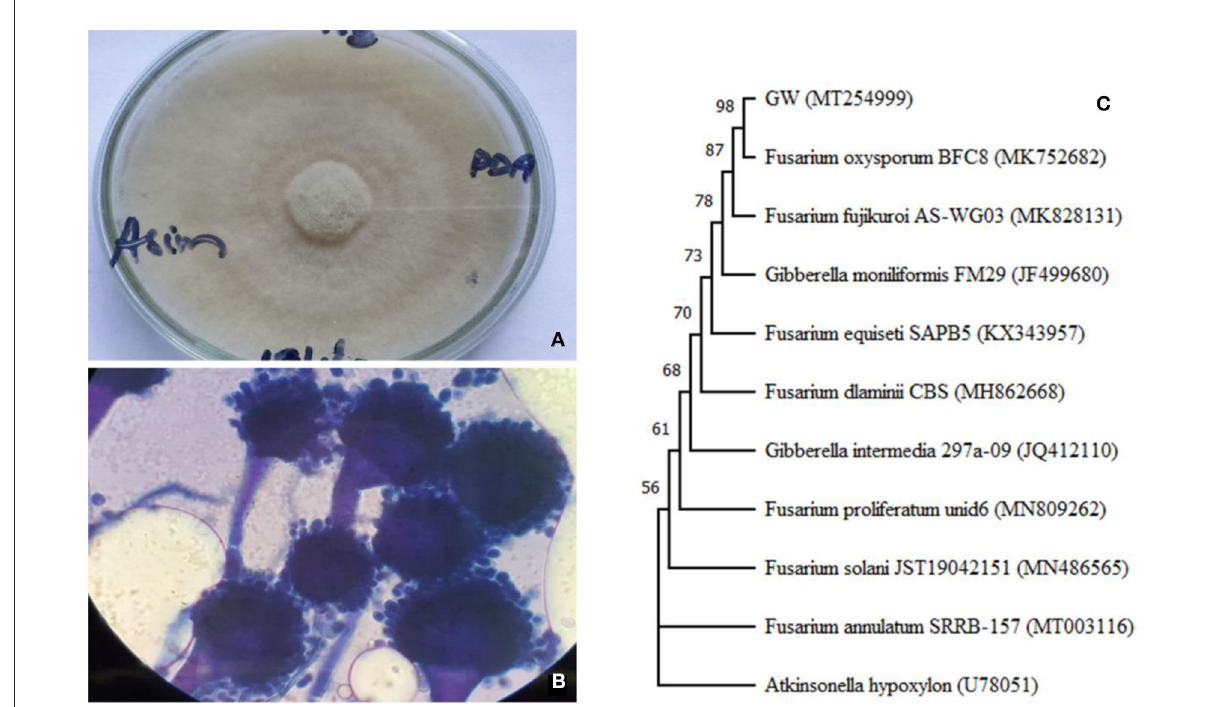
FIGURE1 Colony morphology (A) fungal morphology, (B) light microscopy showing conidiophores at 500 × magnification, and (C) phylogenetic relationship of ITS sequence of Fusarium oxysporum GW isolated during the current study. The neighbor-joining tree was made including the ITS sequence of Atkinsonella hypoxylon (U78051) as an